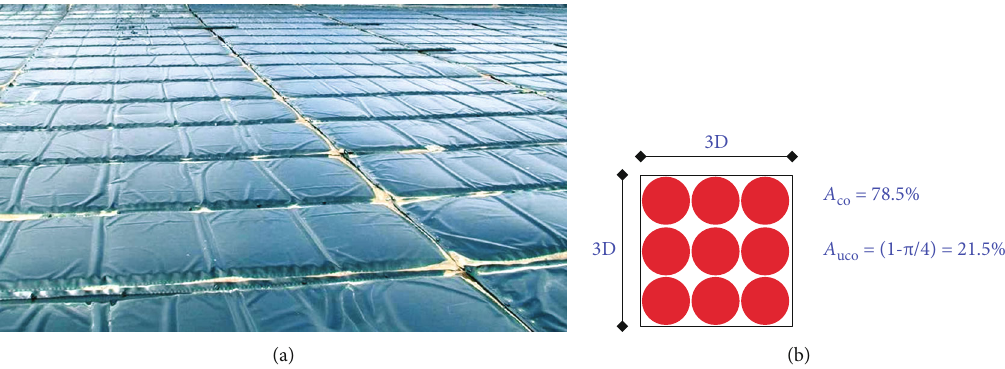
Figure 7: (a) Example of commercial coversheets to prevent evaporation. (b) Proposed circular foam sheets